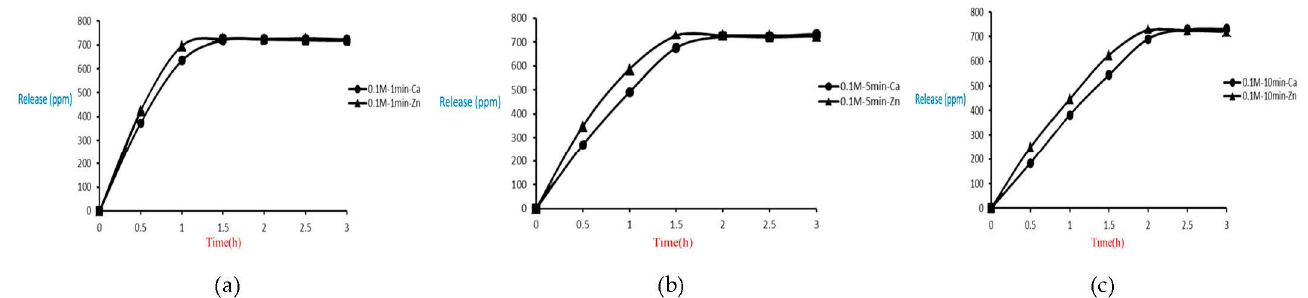
Figure 24. The effect of different cross-linking reagents (0.1 M, cross-linking time of 1 ( a ), 5 ( b ), 10 ( c ) minute) on releasing of tea tree essential oil from alginate/tea tree essential oil microcapsules in the hot spring water.